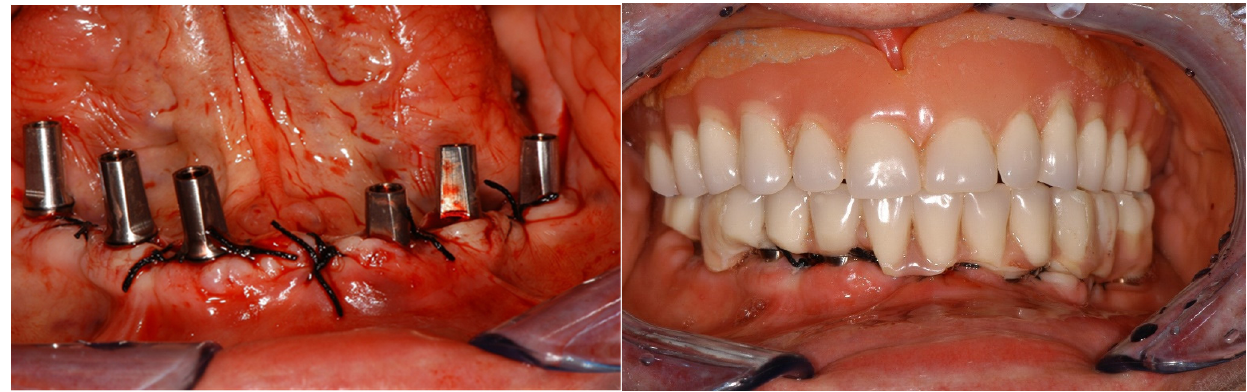
Figure 2. The temporary prosthesis was fixed on the temporary abutment.